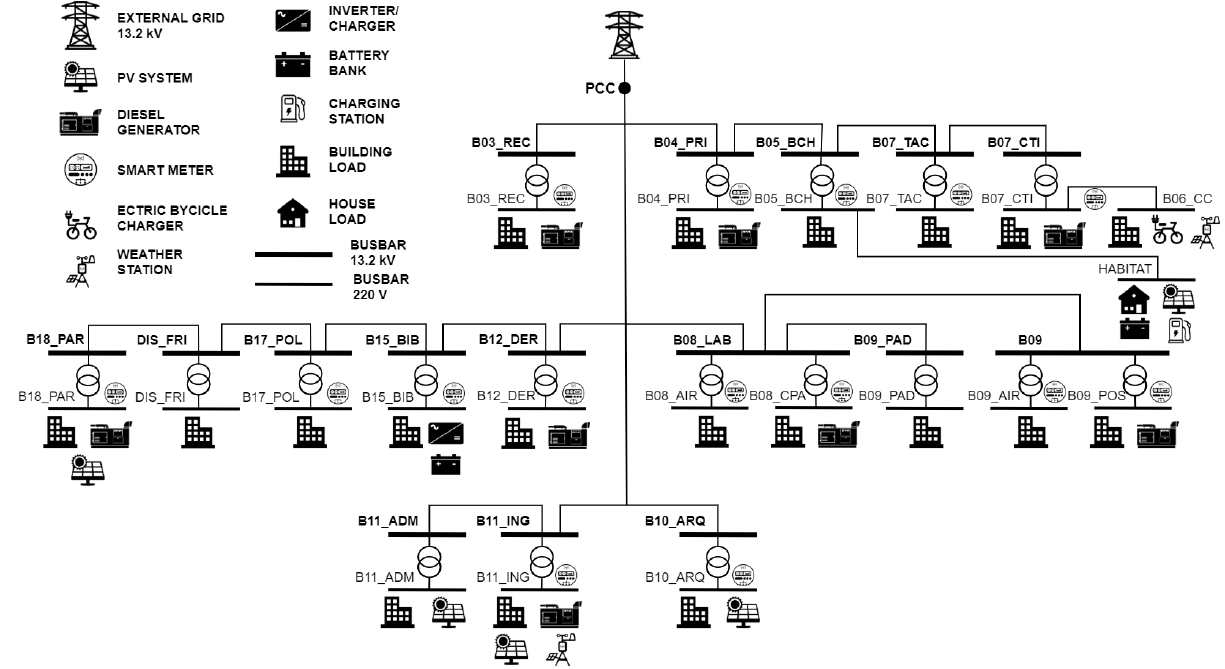
Figure 2. UPB campus microgrid